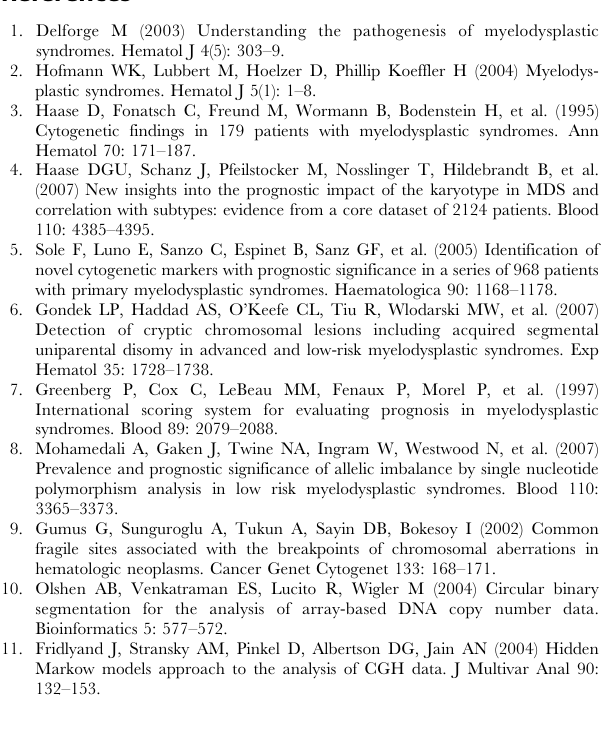
Table S1 Details of the used SNP arrays. The references are marked in shade.